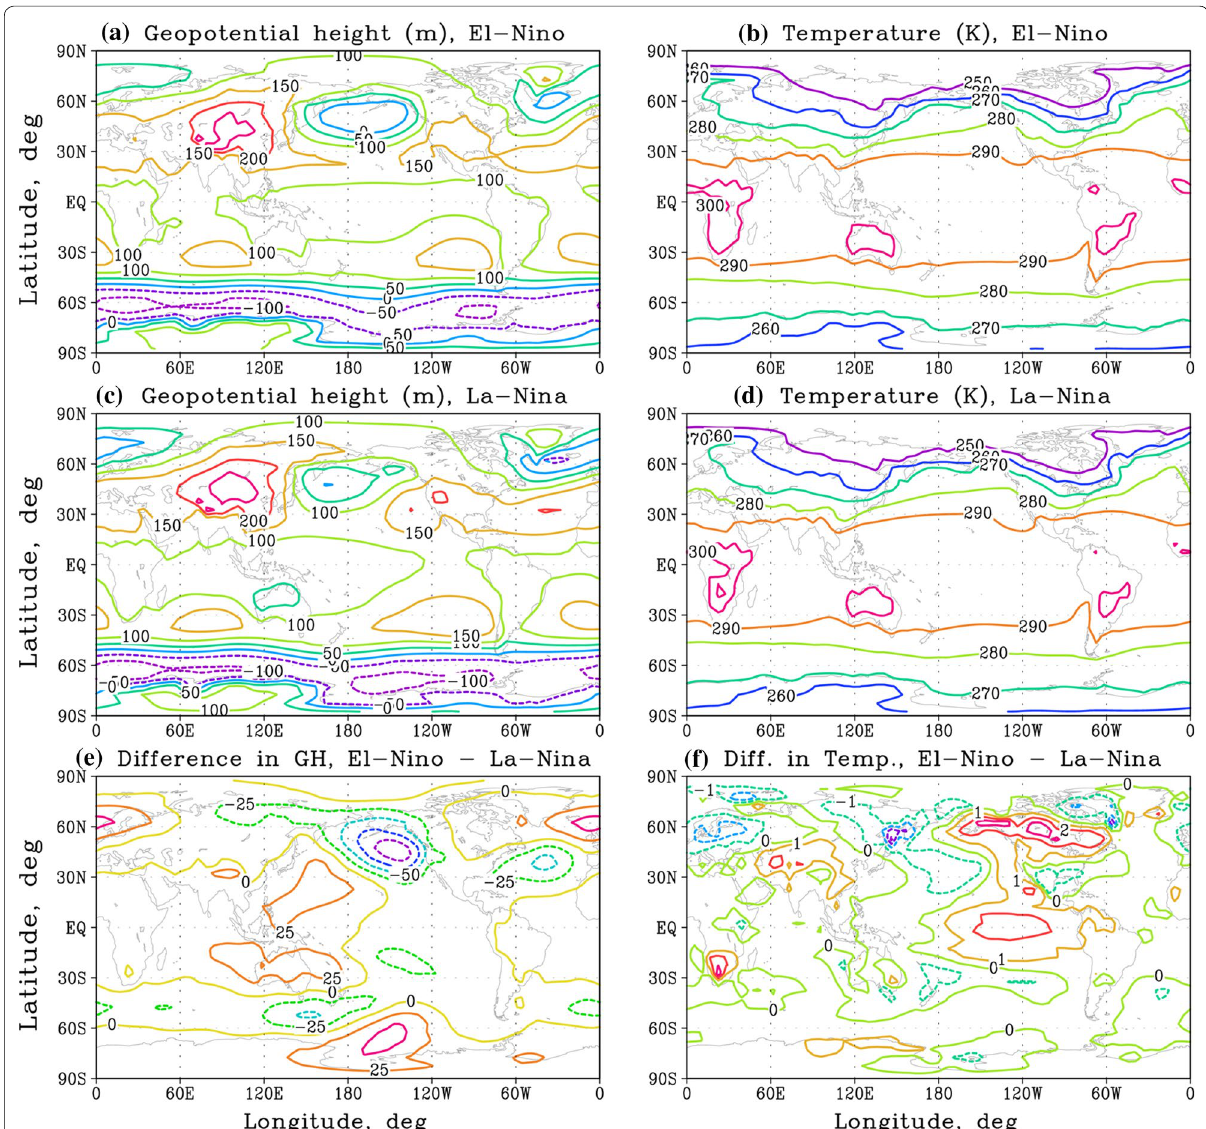
Fig. 3 Monthly mean (January) lower boundary conditions in the geopotential height ( a , c ) and temperature ( b , d ). Top panels correspond to the El Niño and middle panels to the La Niña conditions. Differences in the lower boundary conditions ( e , f